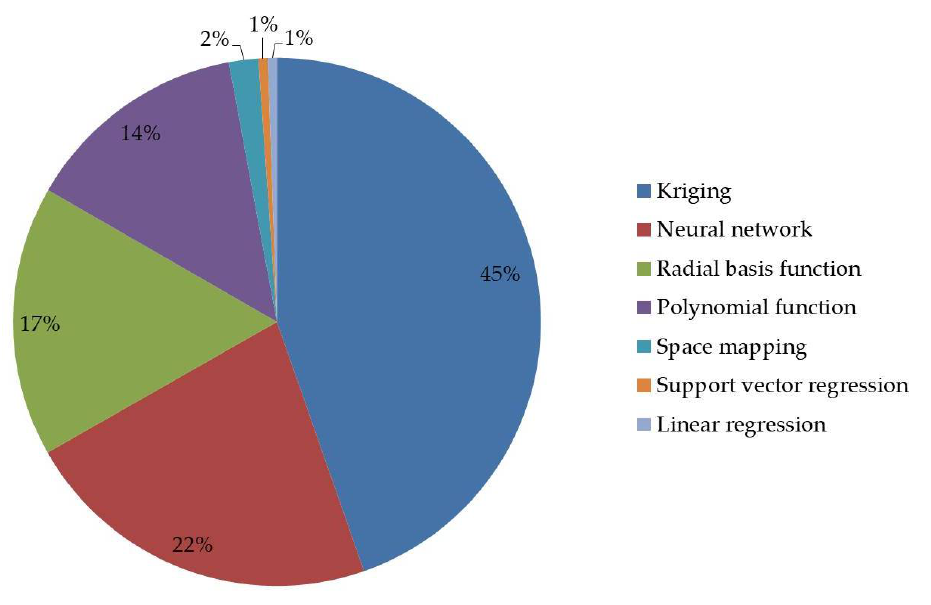
Figure 7. The most often applied surrogate model types in the field of chemical engineering (based on a Scopus search, number of articles: